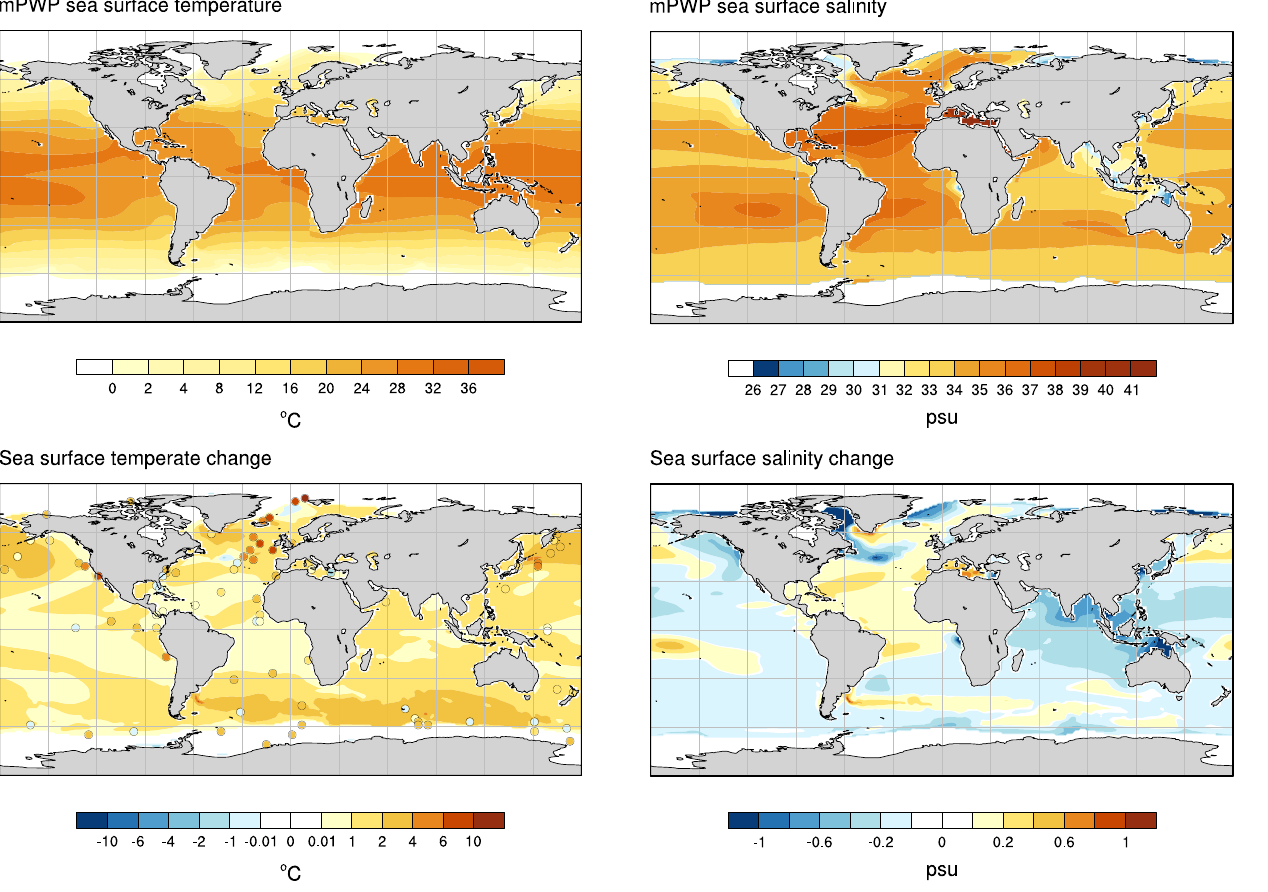
Fig. 6. CCSM4 simulated sea surface salinity (top) and change from PI control (bottom). White polar regions indicate sea ice in the mPWP simulation (top) and both the mPWP and PI simulations